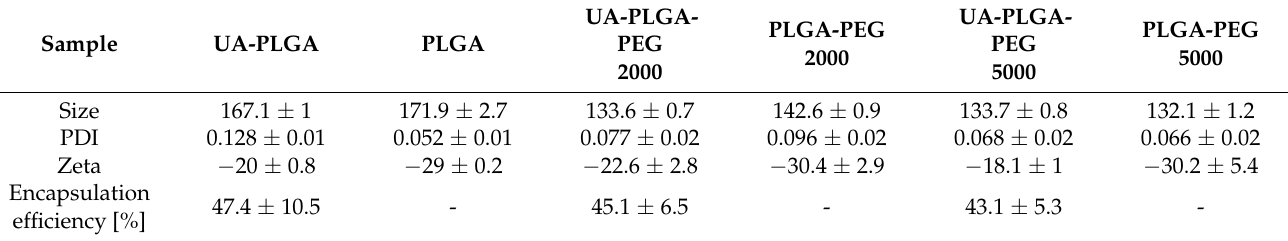
Table 1. Nanoparticle